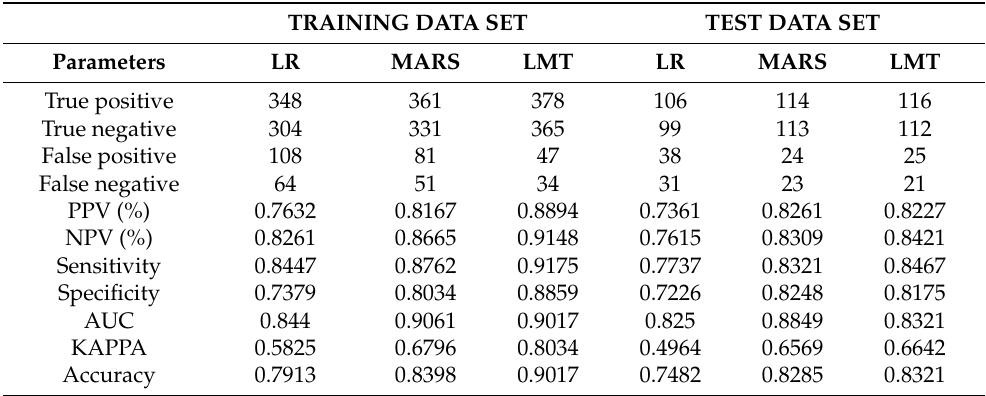
Table 3. Performance of models generated by three statistical techniques. LR: logistic regression. MARS: Multivariate adaptive regression spline. LMT: Logistic model tree.